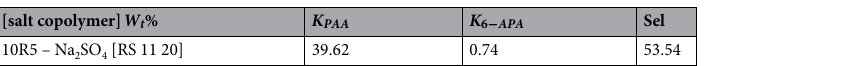
Table 4. Weight percentage composition ( W t %), partition coefficient (K), extraction efficiency (EE%) and selectivity (Sel.) for a mixture of PAA and 6-APA in 10R5- Na 2 SO 4